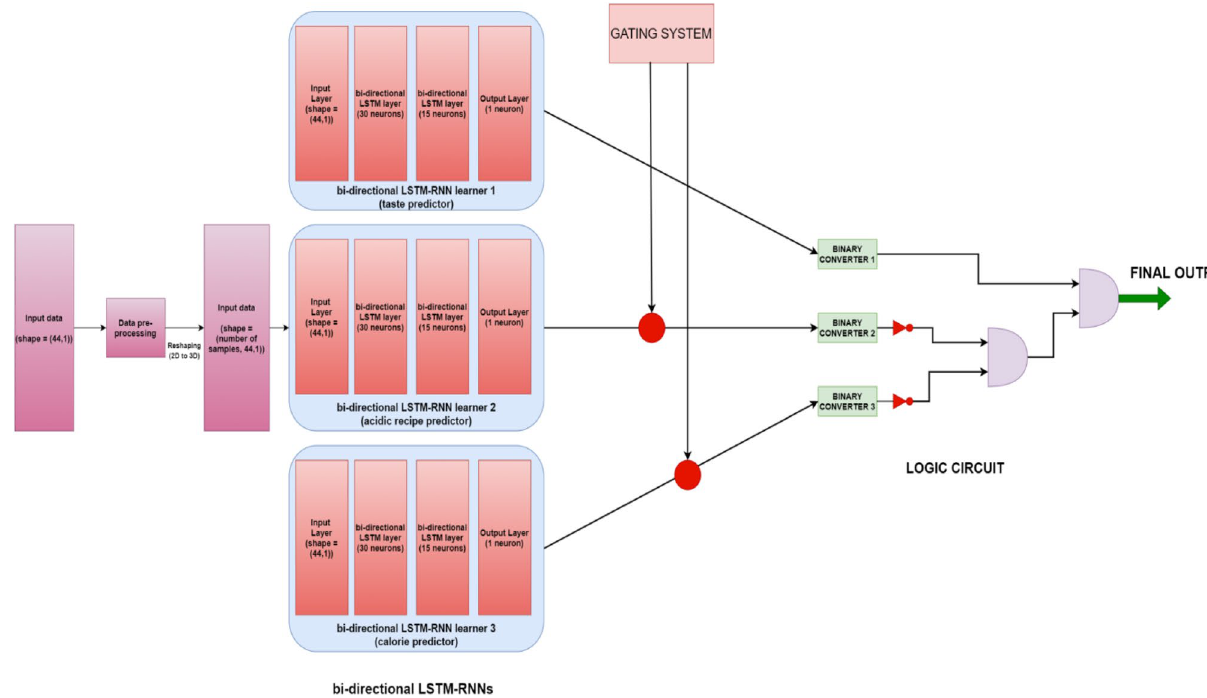
Fig. 1 Bi-directional LSTMs-based ensemble of neural